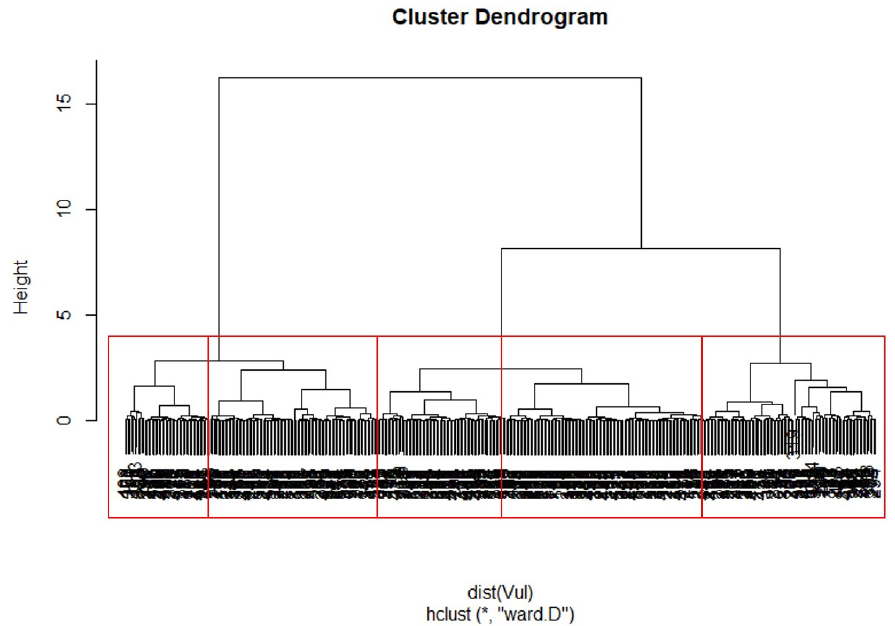
Figure A2. Calinski-Harabasz (C-H) Index Analysis for the level range of vulnerability.